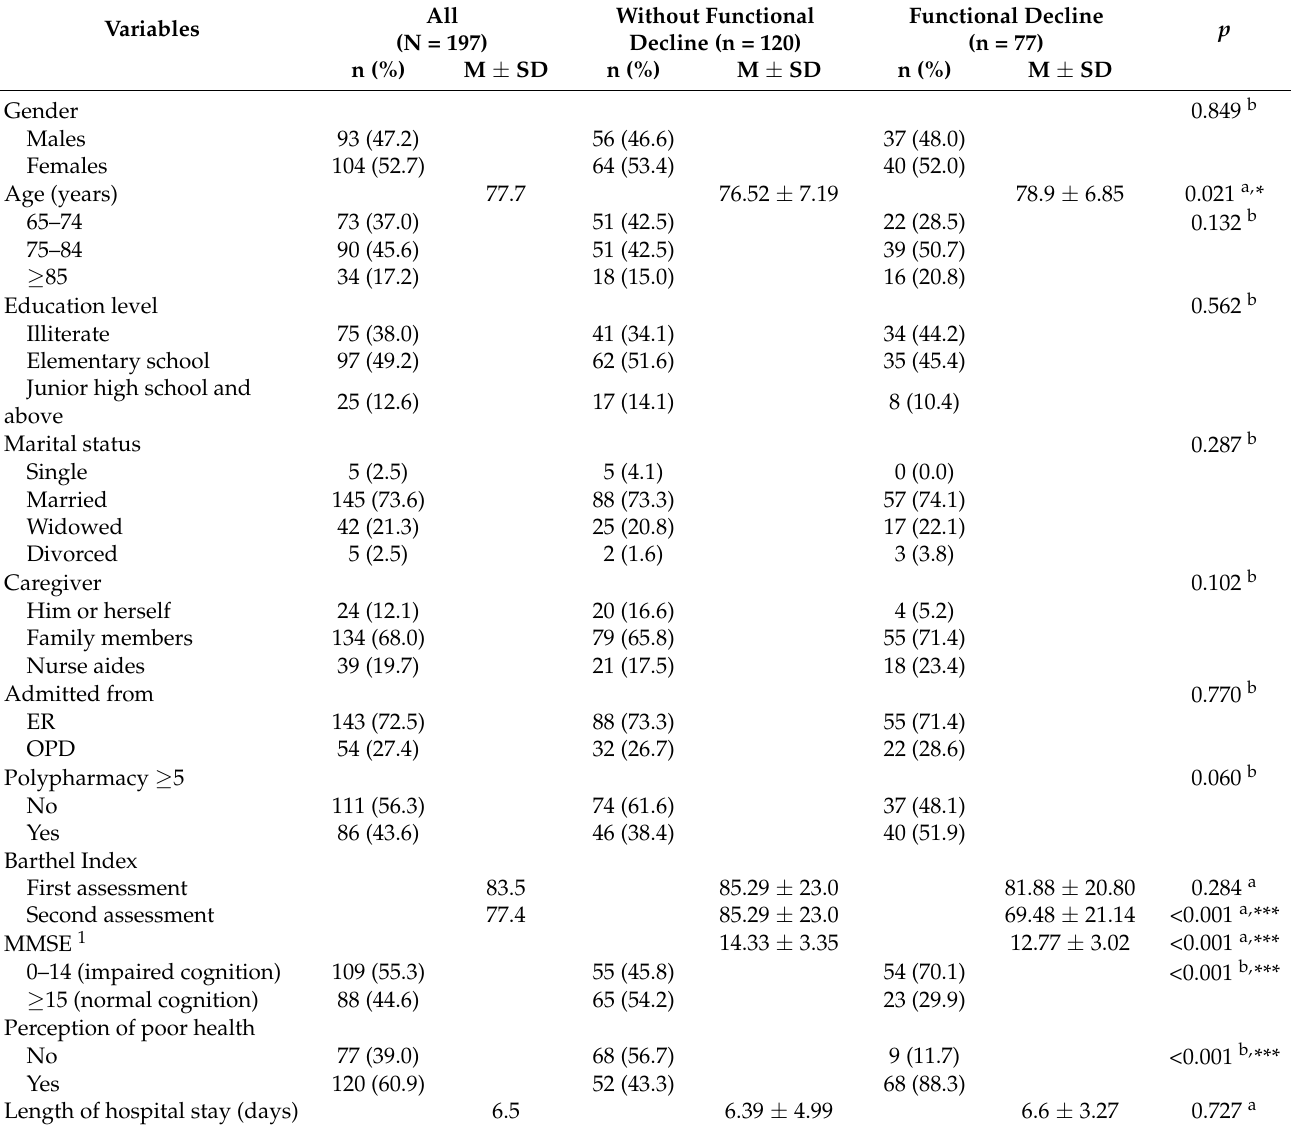
Table 1. Demographic and clinical characteristics of patients with and without functional